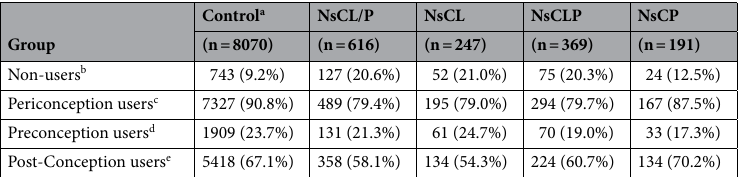
Table 2. Maternal periconceptional folic acid supplementation in cases and controls. NsCL/P, nonsyndromic cleft lip with or without cleft palate cases; NsCL, nonsyndromic cleft lip cases; NsCLP, nonsyndromic cleft lip with cleft palate cases; NsCP, nonsyndromic cleft palate cases. a Significant differences were found between controls, the overall and each subtype of nonsyndromic oral clefts. b Non-users were defined as not having taken folic acid supplements or taken it continuously less than 1 month during the periconceptional period. c Periconception users were defined as having taken folic acid supplements regularly at least 1 month during the periconceptional period. d Preconception users were defined as having taken folic acid supplements regularly